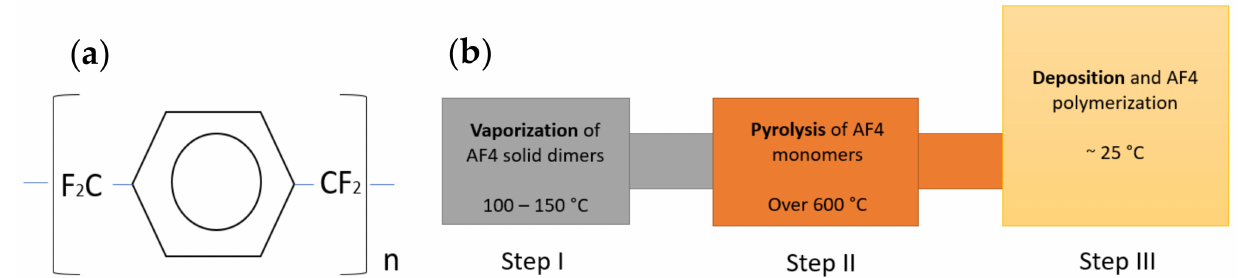
Figure 1. ( a ) Chemical structure of parylene AF4 and ( b ) the Gorham process presented in three steps for depositing AF4